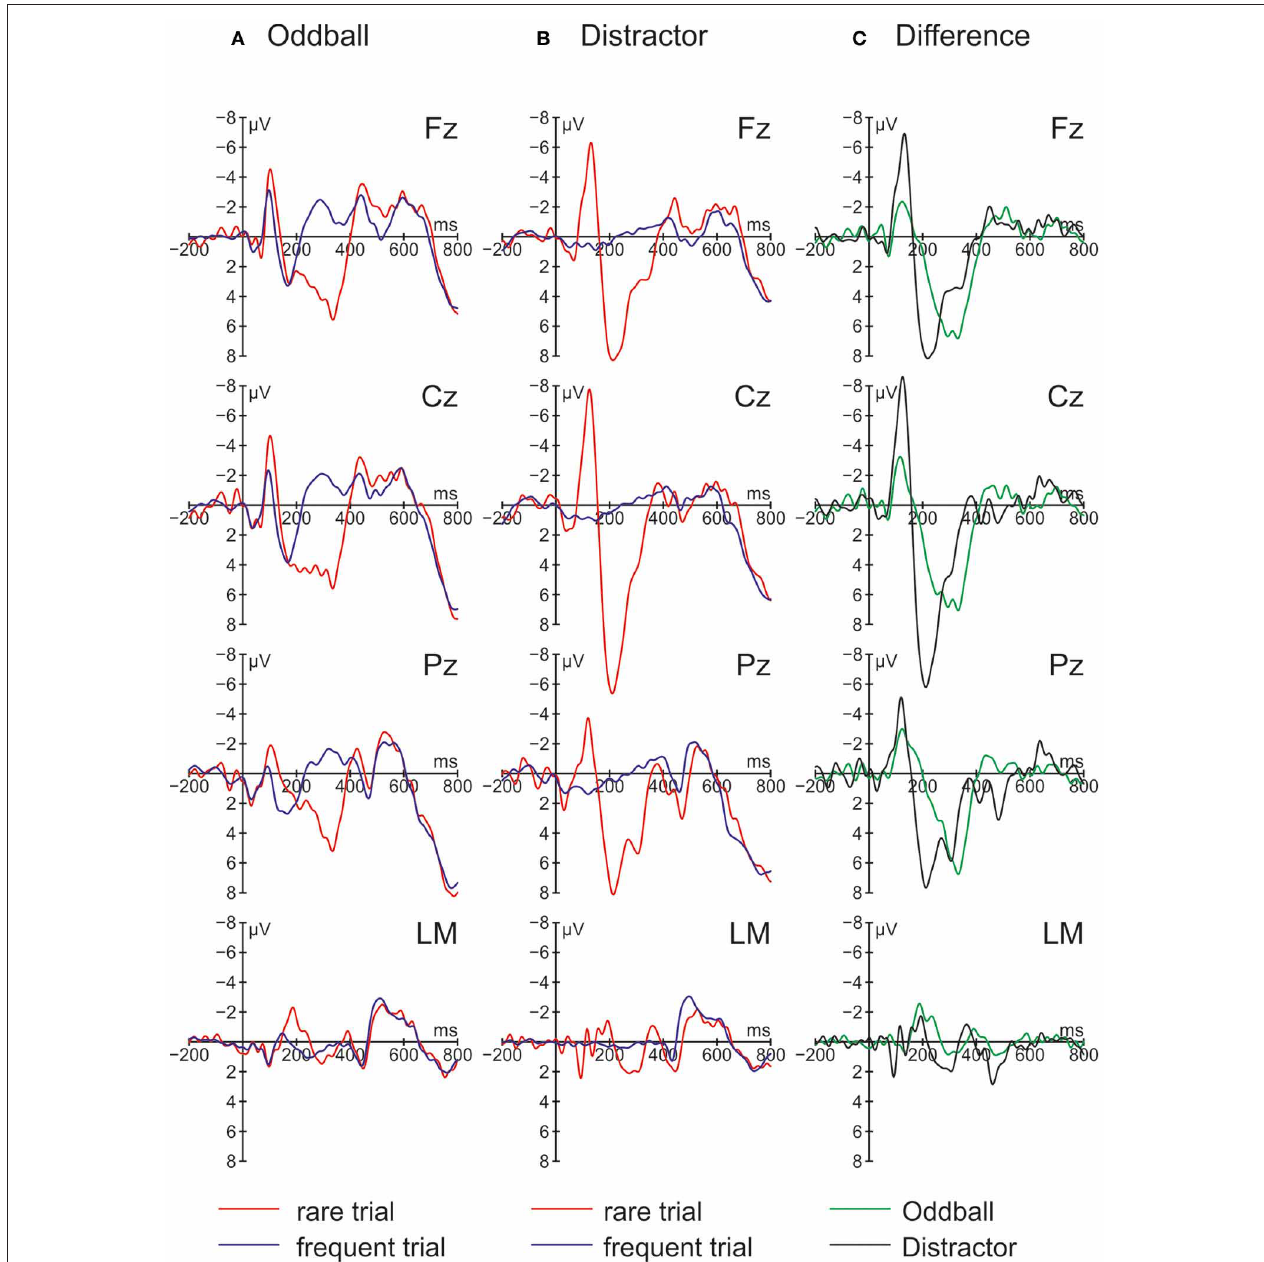
FIGURE 3 | Grand average ERPs for rare and frequent trials in (A) the Oddball condition and (B) the Distractor condition plus (C) Difference waves (i.e., rare trial ERPs minus frequent trials ERPs) obtained in Experiment 2 ( N =